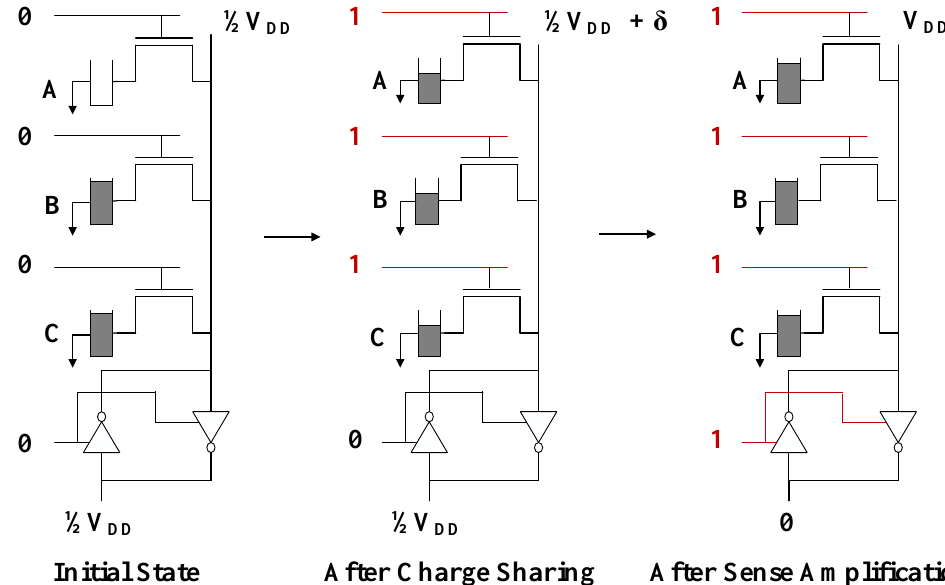
Figure 10. Example of a Triple-Row Activation (TRA) (adapted from